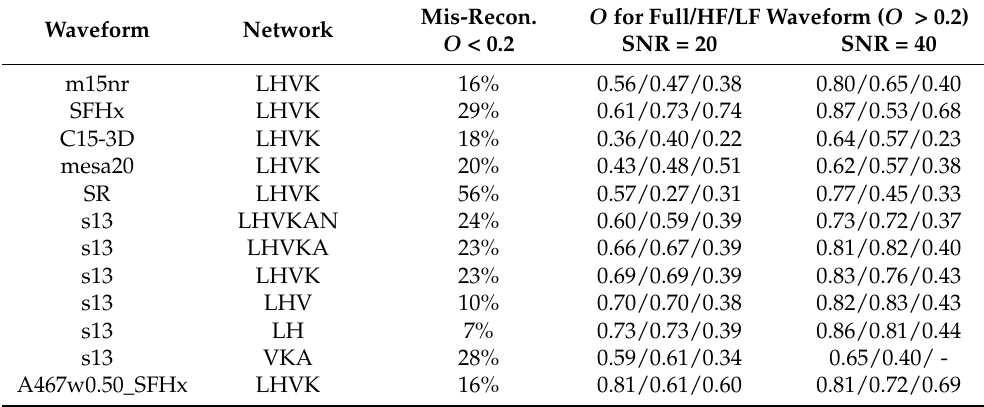
Figure 4. Waveform overlap as a function of injected SNR for m15nr model [30]. The accuracy of the full waveform increases with the SNR. However, in this example, each waveform component is reconstructed less accurately. The numbers in brackets are waveform overlaps at SNR 20 and 40, respectively, (for O > 0.2). Table 3. Waveform overlaps for all waveforms and example detector networks. The reconstruction accuracy depends on the waveforms morphology and typically the waveform component is larger for the part of the signal with the peak